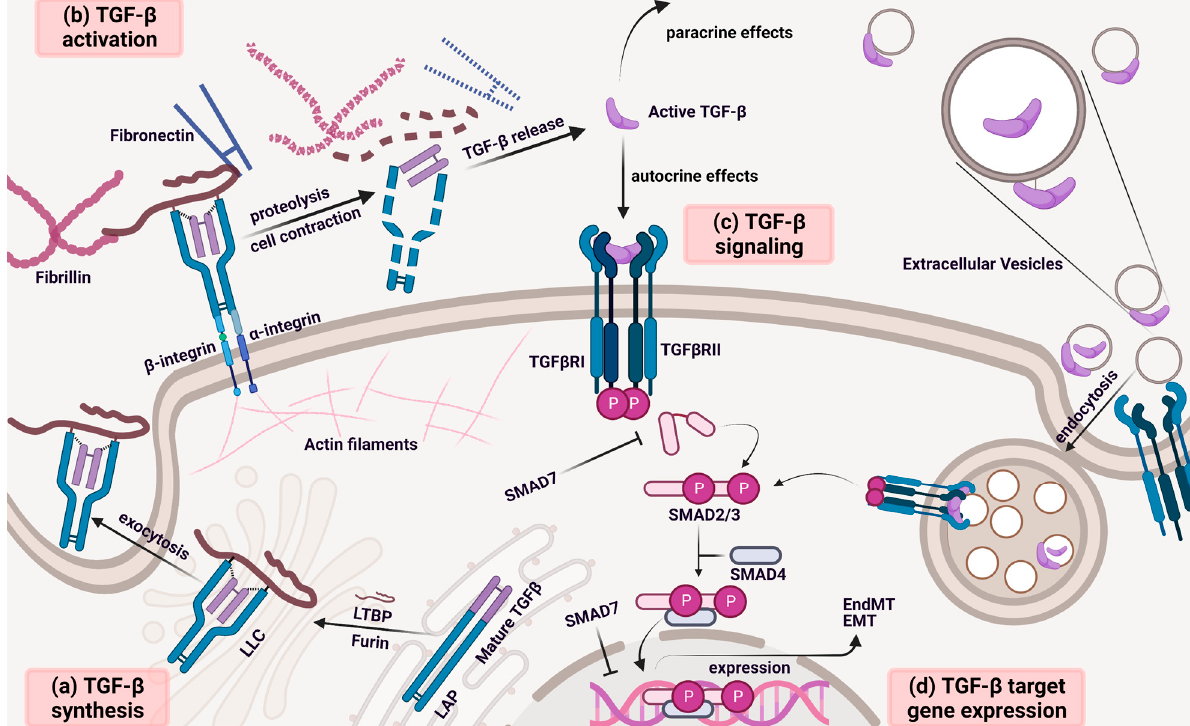
Figure 1. TGF- β activation and canonical SMAD signaling. The signaling of TGF- β family members is based on the activation of type I and type II dual-specificity serine/threonine kinase receptors at the surface of target cells. The type of activated receptor determines the final cellular response to active peptide ligand stimulation. ( a ) TGF- β is synthesized via ribosomes attached to the ER and then converted in the ER lumen to dimeric pro-TGF- β , the monomer of which consists of an LAP and a mature TGF- β fragment. Then, it crosslinks with the LTBP, forming an LLC. The dimer is cleaved by furin convertase in the Golgi complex, whereby it binds non-covalently to mature TGF- β and prevents TGF- β from binding to cell-surface receptors. Thereupon, LLC accumulates in secretory vesicles, which exocytose into the ECM. ( b ) The LLC is located in the ECM and crosslinks to fibrillin and fibronectin and binds to integrin receptors. The release and activation of mature TGF- β require a change in the LLC conformation triggered by a contraction force transmitted from integrin-associated actin filaments or proteolytic cleavage of fibrillin, fibronectin, LTBP, and LAP. ( c ) The active ligand